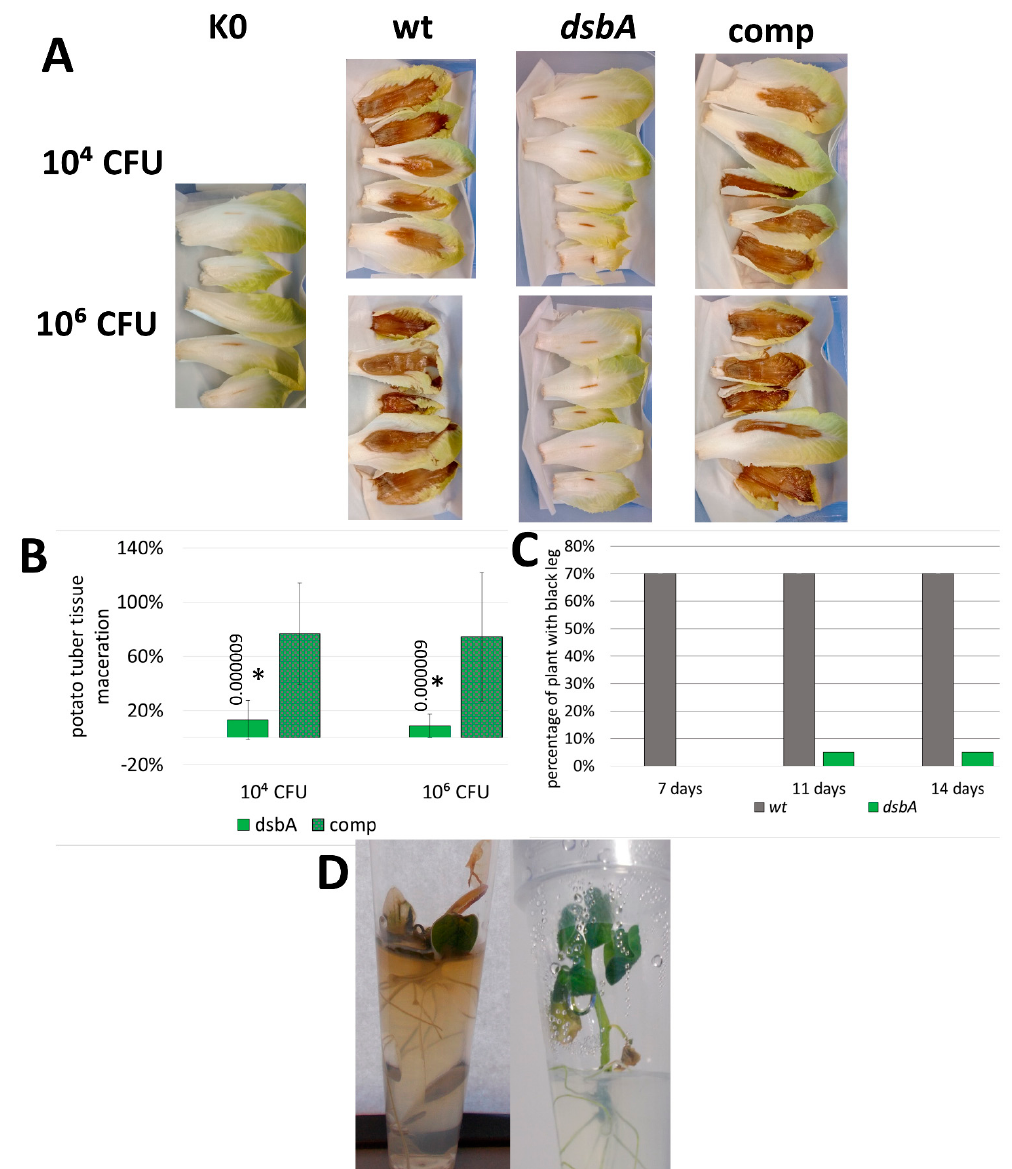
Figure 4. Influence of the dsbA mutation on the D. solani virulence. For the virulence tests, maceration of plant tissues was evaluated on isolated plant parts ( A , B ) and in planta infection assays were performed on whole plants ( C , D ). ( A ) Representative examples of chicory leaf infections. Five independent biological replicates of each strain and bacterial inoculum were analyzed. ( B ) Relative values of potato tuber maceration caused by the mutant TP02 ( dsbA ) and the complemented strain TP03 (comp) expressed as percentages of maceration caused by the wt D. solani cells. The weight of tissue macerated by wild-type bacteria was set at 100%. Per set of strains, nine individual tubers were inoculated in two independent experiments ( n = 18). Statistical analysis of differences was determined by two-way analysis of variance (ANOVA) test followed by a post hoc Dunnett test. The result was considered significant at p < 0.05; the numbers next to asterisks show the actual p -values. ( C ) Percentage of the potato plants showing black leg symptoms in the pot assay. Five independently grown cultures of each bacterial strain were used in the assay. Each culture was used to infect 4 potato plants, giving 20 plants per strain ( n = 20). Inoculated plants were visually inspected 7, 11 and 14 days post infection for wilting, typical blackleg symptoms and plant death. ( D ) Representative examples of the potato plantlets infected with D. solani wt (left) and D. solani dsbA